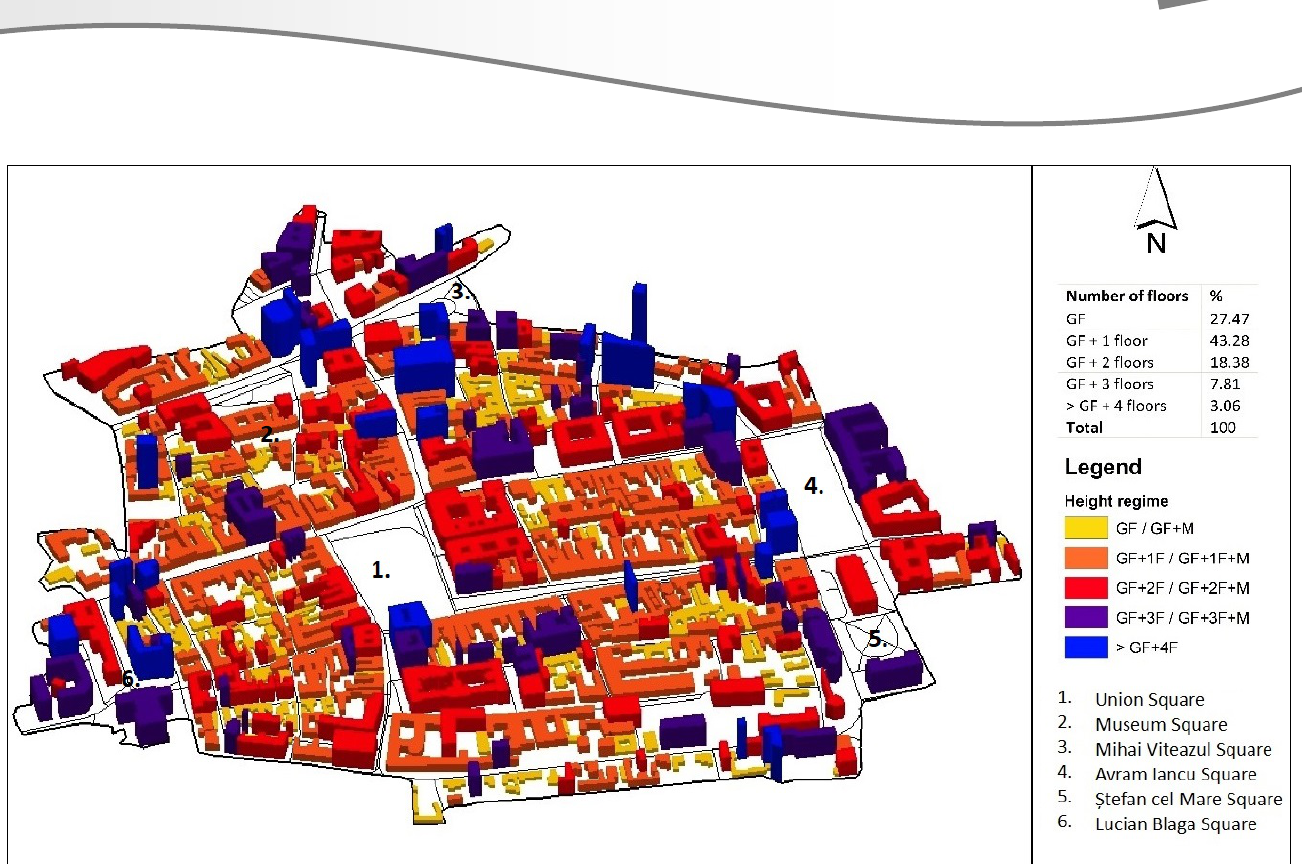
Figure 3 : Three-dimensional perspective of the current height regime of buildings in the central area Cartography: Emanuel-Cristian ADOREAN,